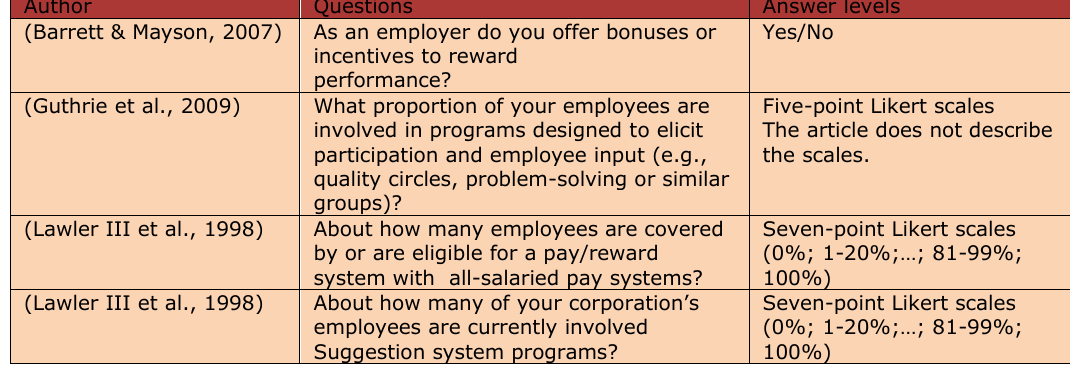
Table 3. Question samples from type A questionnaires